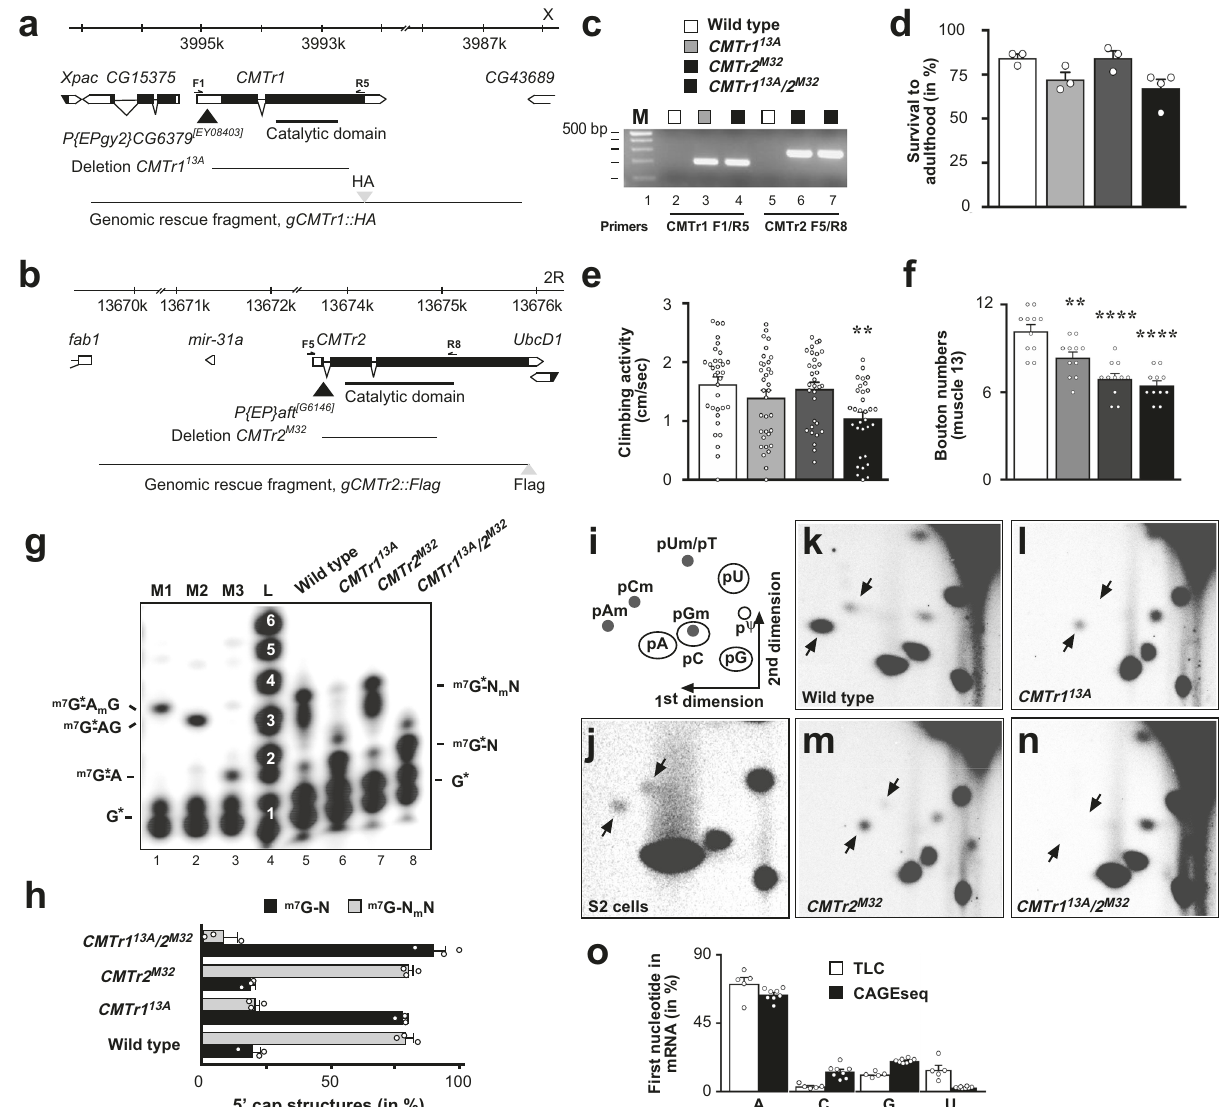
Fig. 1 Analysis of CMTr1 and CMTr2 null mutants and mRNA cap 2 ′ - O -ribose methylation in Drosophila . a , b Genomic organization of the CMTr1 and CMTr2 loci depicting the transposons (black triangle) used to generate the deletions 13A and M32 , which are null alleles. Genomic rescue fragments tagged either with hemaglutinin (HA, a ) or FLAG ( b ) epitopes are indicated at the bottom. Primers used for validating the deletions are indicated on top of the transcript. c Validation of CMTr1 13A and CMTr2 M32 single and double mutants by genomic PCR. The gel is representative of two biological replicates. The marker is a 100 bp DNA ladder with 500 bp indicated on top. Wild type is indicated in white, CMTr1 13A in light gray, CMTr2 M32 in dark gray, and CMTr1 13A / 2 M32 in black. d Survival of fl ies to adulthood after hatching from the eggshell shown as mean ±SE ( n = 3, except CMTr1 13A / 2 M32 n = 4). e Climbing activity was assessed by negative geotaxis assays shown as mean ± SE, n = 40, p = 0.005 by one-way ANOVA followed by Tukey ’ s test. f Bouton numbers at NMJs of muscle 13 in third instar larvae are shown as mean ± SE. n = 11, ** p = 0.005 and **** p ≤ 0.0001 by one-way ANOVA followed by Tukey ’ s test. g Recapping of mRNA with 32 PalphaGTP from adult fl ies of the indicated genotypes. 5 ′ cap structures were separated on 20% denaturing polyacrylamide gels after digestion with RNAse I (lanes 5 – 8, right) Markers — M1: RNAse I digested 32 PalphaGTP capped in vitro transcript starting with AGU and 2 ′ - O - ribose methylated with vaccinia CMTr. M2: RNAse T1 digested 32 PalphaGTP capped in vitro transcript starting with AGU. M3: RNAse I digested 32 PalphaGTP capped in vitro transcript starting with AGU. Sequences of markers are shown on the left and of cap structures from adult fl ies are shown on the right, N: any nucleotide, *: 32 P, m: methyl-group. L: single nucleotide ladder with nucleotide number indicated in white made by alkaline hydrolysis of a 5 ′ 32 P-labeled RNA oligonucleotide. h Quanti fi cation of 5 ′ cap structures shown as mean ± SE. n = 3. Non-ribosemethylated cap is in black and ribose methylated in gray. i Schematic diagram of a 2D thin-layer chromatography (TLC) depicting standard and 2 ′ - O -ribose methylated (m) phospho- nucleotides. ψ : pseudouridine. j – n Representative TLCs from three replicates showing modi fi cations of the fi rst cap-adjacent nucleotides of S2 cells (je), adult control ( k ), and CMTr1 13A and CMTr2 M32 single ( l , m ) and double ( n ) mutant females. o Quanti fi cation of the mRNA fi rst nucleotide shown as mean ± SE from TLC ( n = 5, white) and CAGEseq data ( n = 8, black) from adult Drosophila and S2 cells, respectively. Source data for gels, survival to adulthood, climbing activity, bouton numbers at muscle 13, for 5 ′ cap structures, and fi rst nucleotide in mRNA are provided as a Source Data fi le.